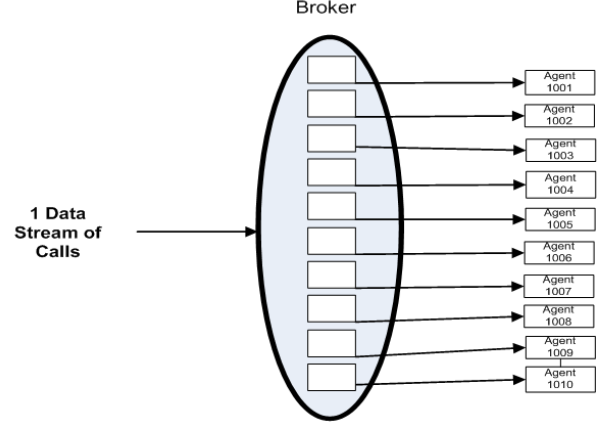
Figure 3 . Agent personalized call center broker system